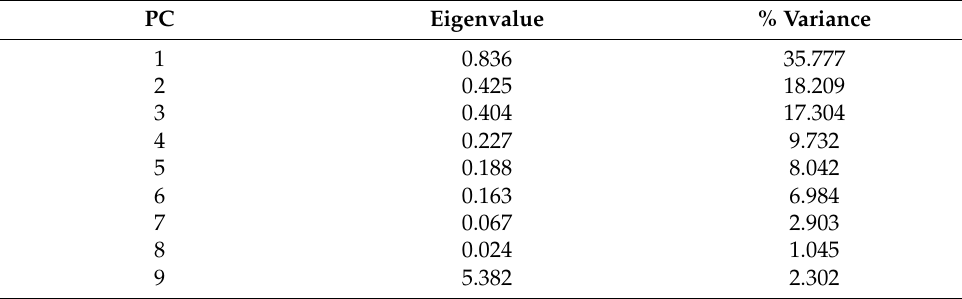
Figure 8. Chart box plot of the diameters of the pollen grains. Populations codes are according to Table 4. Different quantitative characters graph of polar length ( A ), polar width ( B ), equatorial length ( C ), equatorial width ( D ), and P/E ratio ( E ). Table 6. PCA summary with eigenvalue and percentage variance.